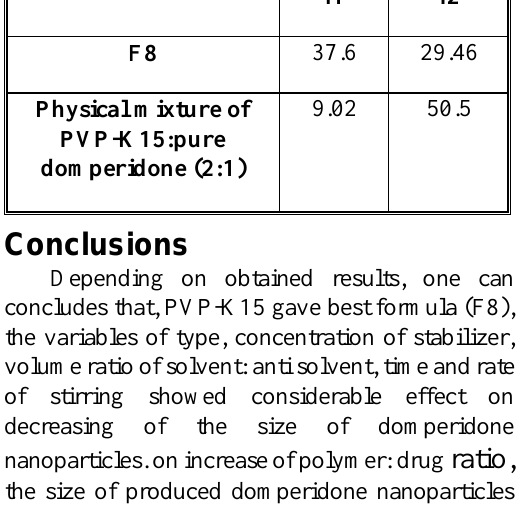
Table 4. Difference and similarity test ( f1 and f2) of selected formula and physical mixture of PVP-K15:pure domperidone (2:1) compared versus pure domperidone f1